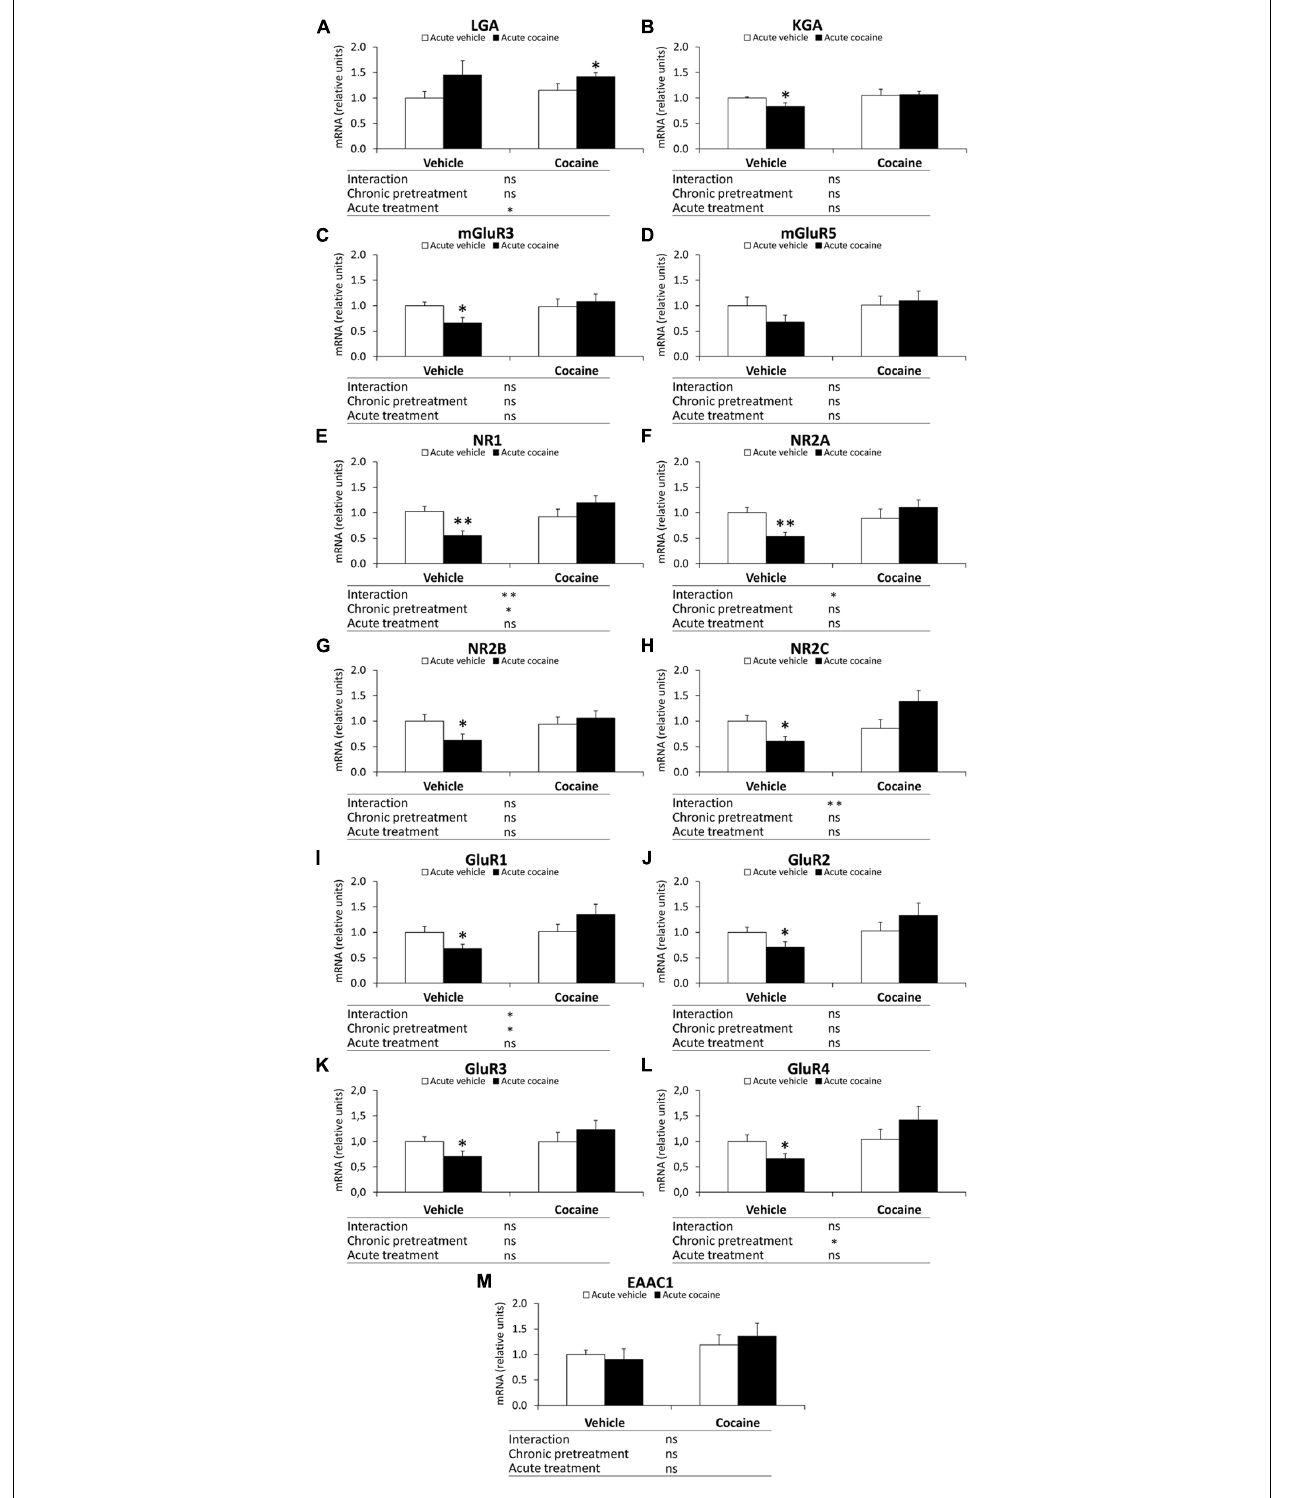
FIGURE 4 | Relative mRNA levels of components of the glutamate signaling system [LGA (A), KGA (B), mGluR3/5 (C,D), NR1/2A/2B/2C (E–H), and GluR1/2/3/4 (I–L) and EAAC1 (M)] in the mouse cerebellum after chronic pretreatment (vehicle and cocaine) and